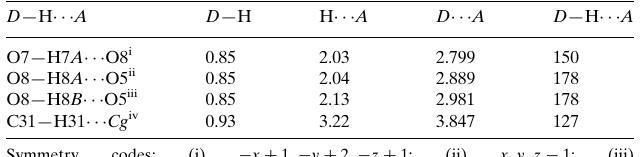
Hydrogen-bond geometry (A˚ , (cid:2)